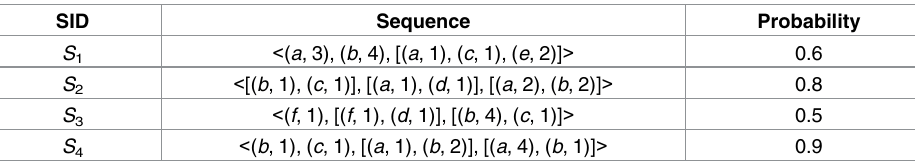
Table 1. An uncertain quantitative sequence